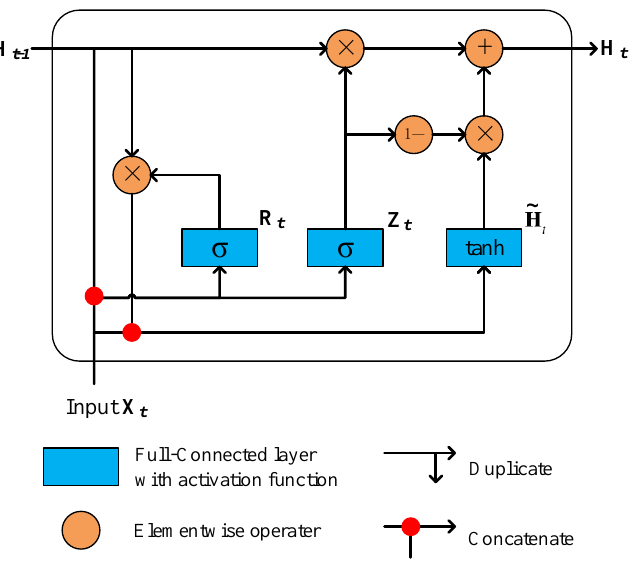
Figure 2. The architecture of a gated recurrent unit (GRU)